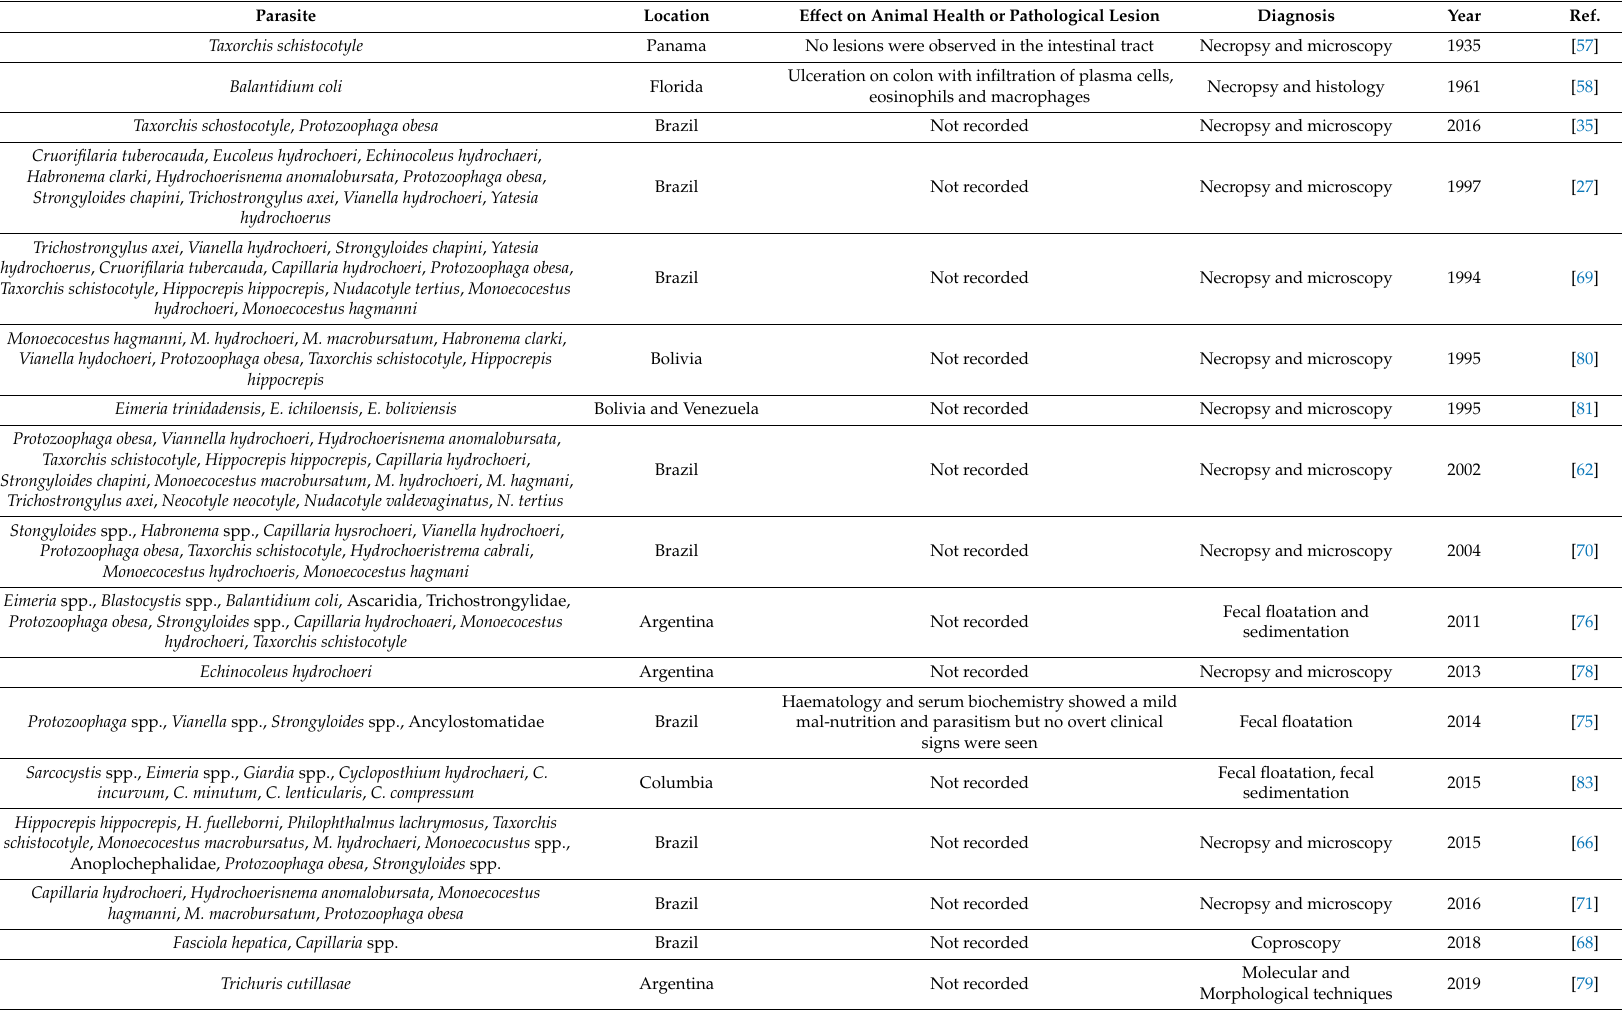
Table 3. Endoparasites found in the Capybara ( Hydrochoeris hydrochaeris ) at di ff erent